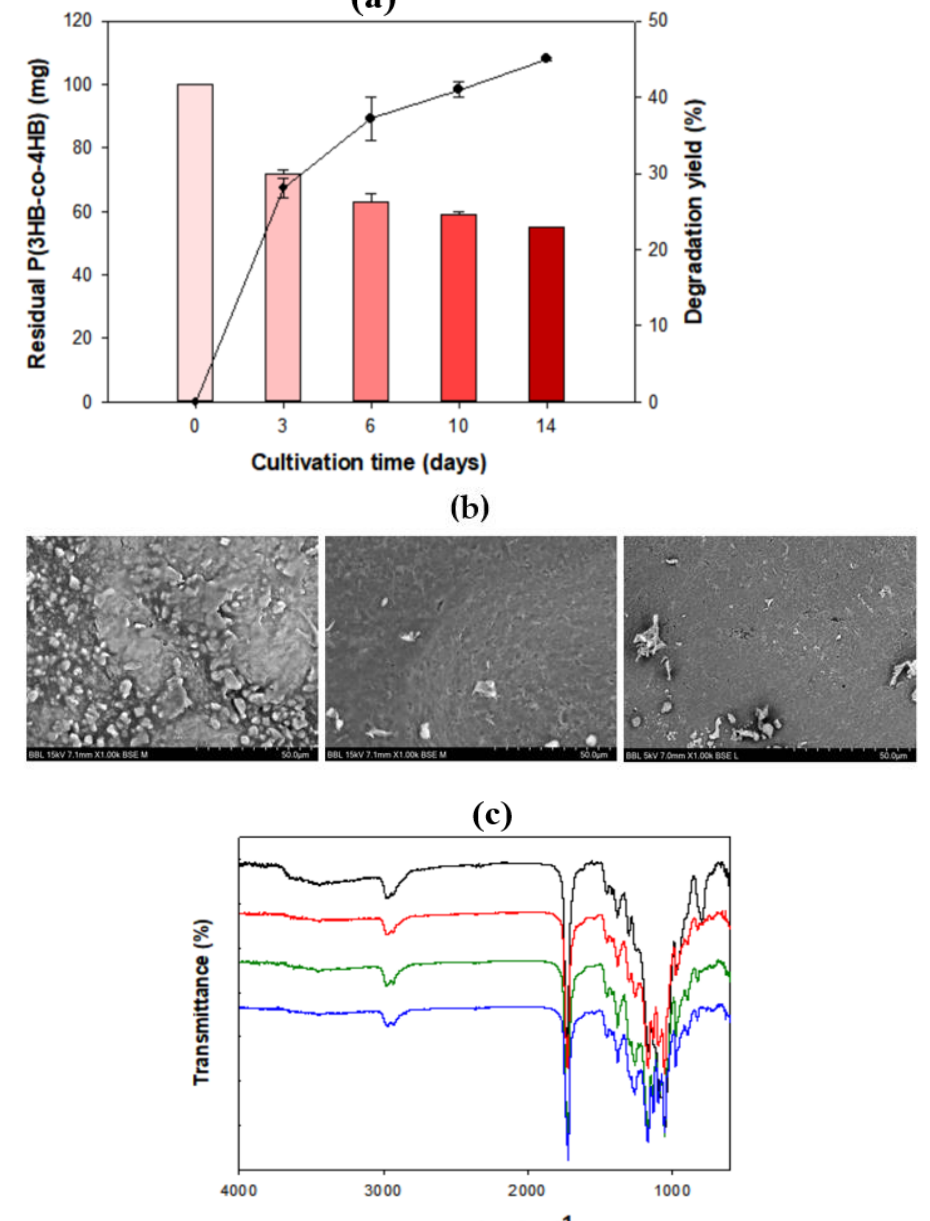
Figure 6. Biodegradability on the pellet of poly(3-hydroxybutyrate- co -4-hydroxybutyrate) [P(3HB-co-4HB)]. ( a ) Microbulbifer sp. SOL66 was cultured with P(3HB-co-4HB) pellets in a liquid marine broth (MB) medium, and the residual pellets were collected and weighed using an electronic scale. ( b ) The surface change of the degraded pellets was observed using scanning electron microscopy (SEM). The images are obtained with a sample of the control, 6 d, and 10 d, respectively. ( c ) Changes in Fourier transform infrared spectroscopy (FT-IR).